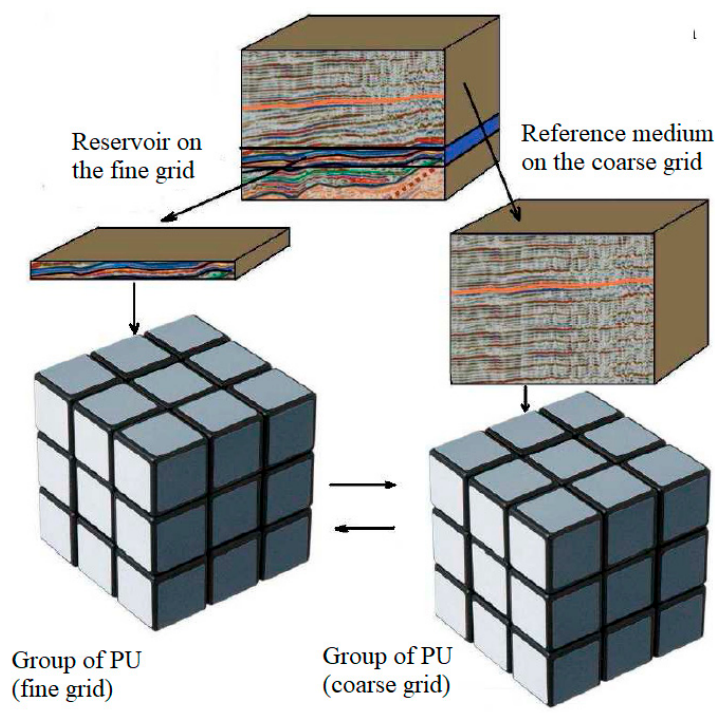
Figure 1. Coarse—fine grid decomposition.